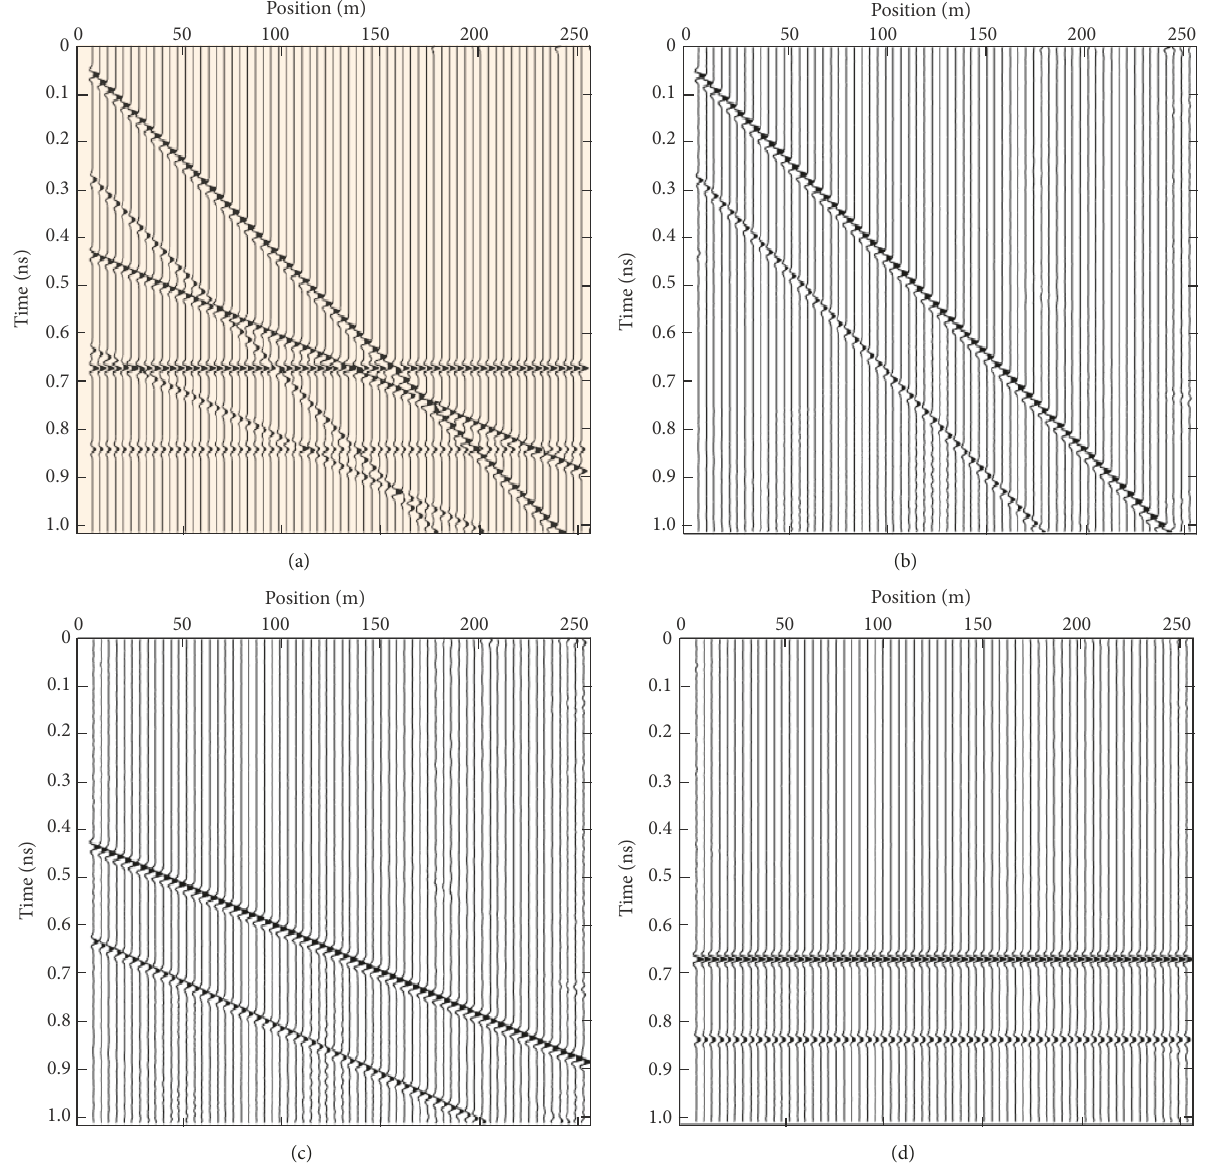
Figure 4: Demonstration of dip filter using f-x EMD. (a) The synthetic data, (b) high-pass dip filtered data, (c) mid-pass dip filtered data, (d) low-pass dip filtered